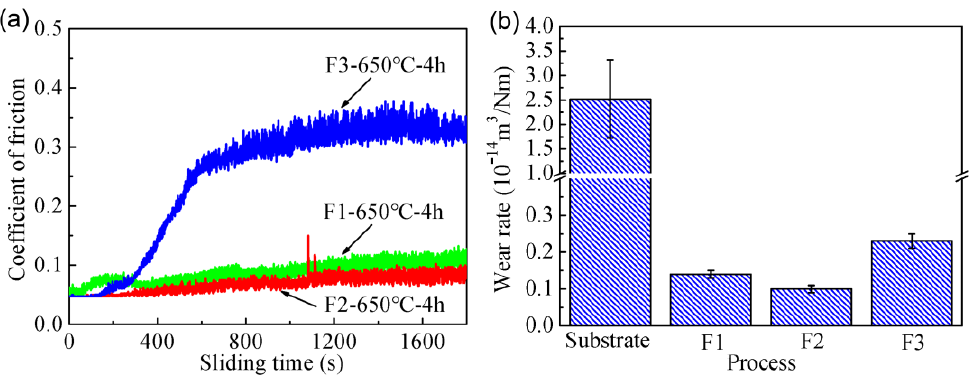
Figure 13. Friction coefficient and wear rate of the Cu-Ti films after plasma nitriding at 650 °C for 4 h: ( a ) friction coe ffi cient and ( b ) wear rate. ( a ) friction coefficient and ( b ) wear rate.